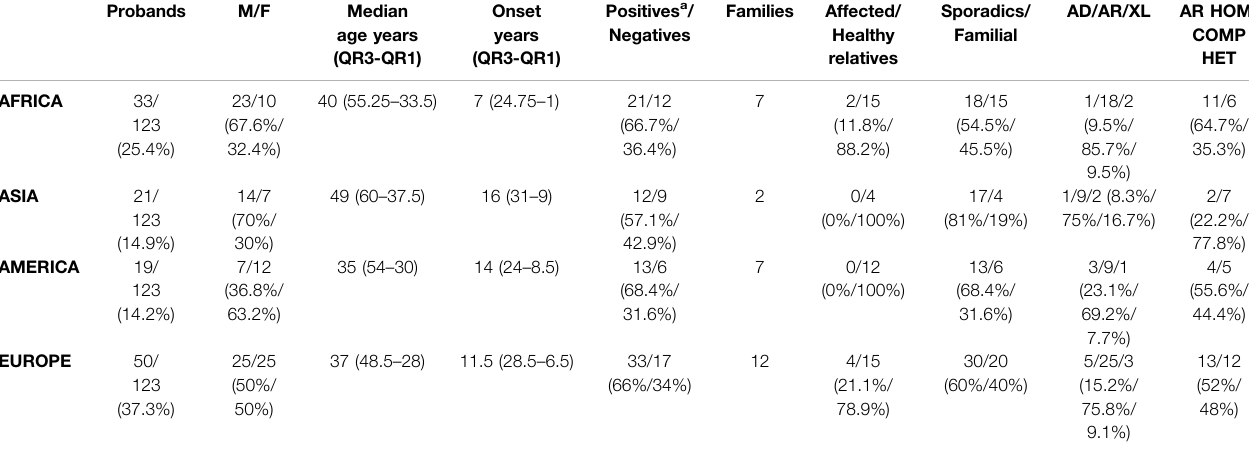
TABLE1| Characteristicsofthestudiedpopulations.Bycomparingthemedianageatonsetofthewholepopulation(13 years,IQR27.25 – 5)withthosederivedfromeachof thefourcontinents,therewasnotstatisticaldifferences( p =0.29AfricaVs.All; p =0.26AsiaVs.All; p =0.89AmericaVs.All; p =0.87EuropeVs.All).Legend:M,male;F, female; AD, autosomal dominant; AR, autosomal recessive; XL, X-linked; HEM, COMP HET, compound heterozygous; HOM,